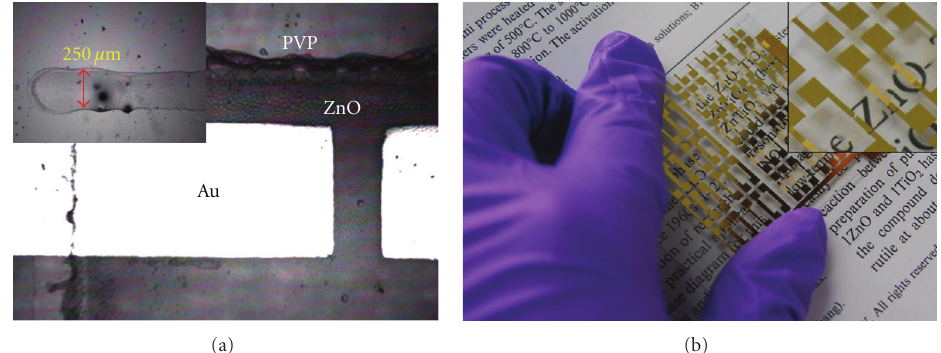
Figure 3: Photos of inkjet-printed patterns obtained from ZnO NPs ink (3wt%) as a function: (a) microscope images; (b) the devices on a glass substrate on one